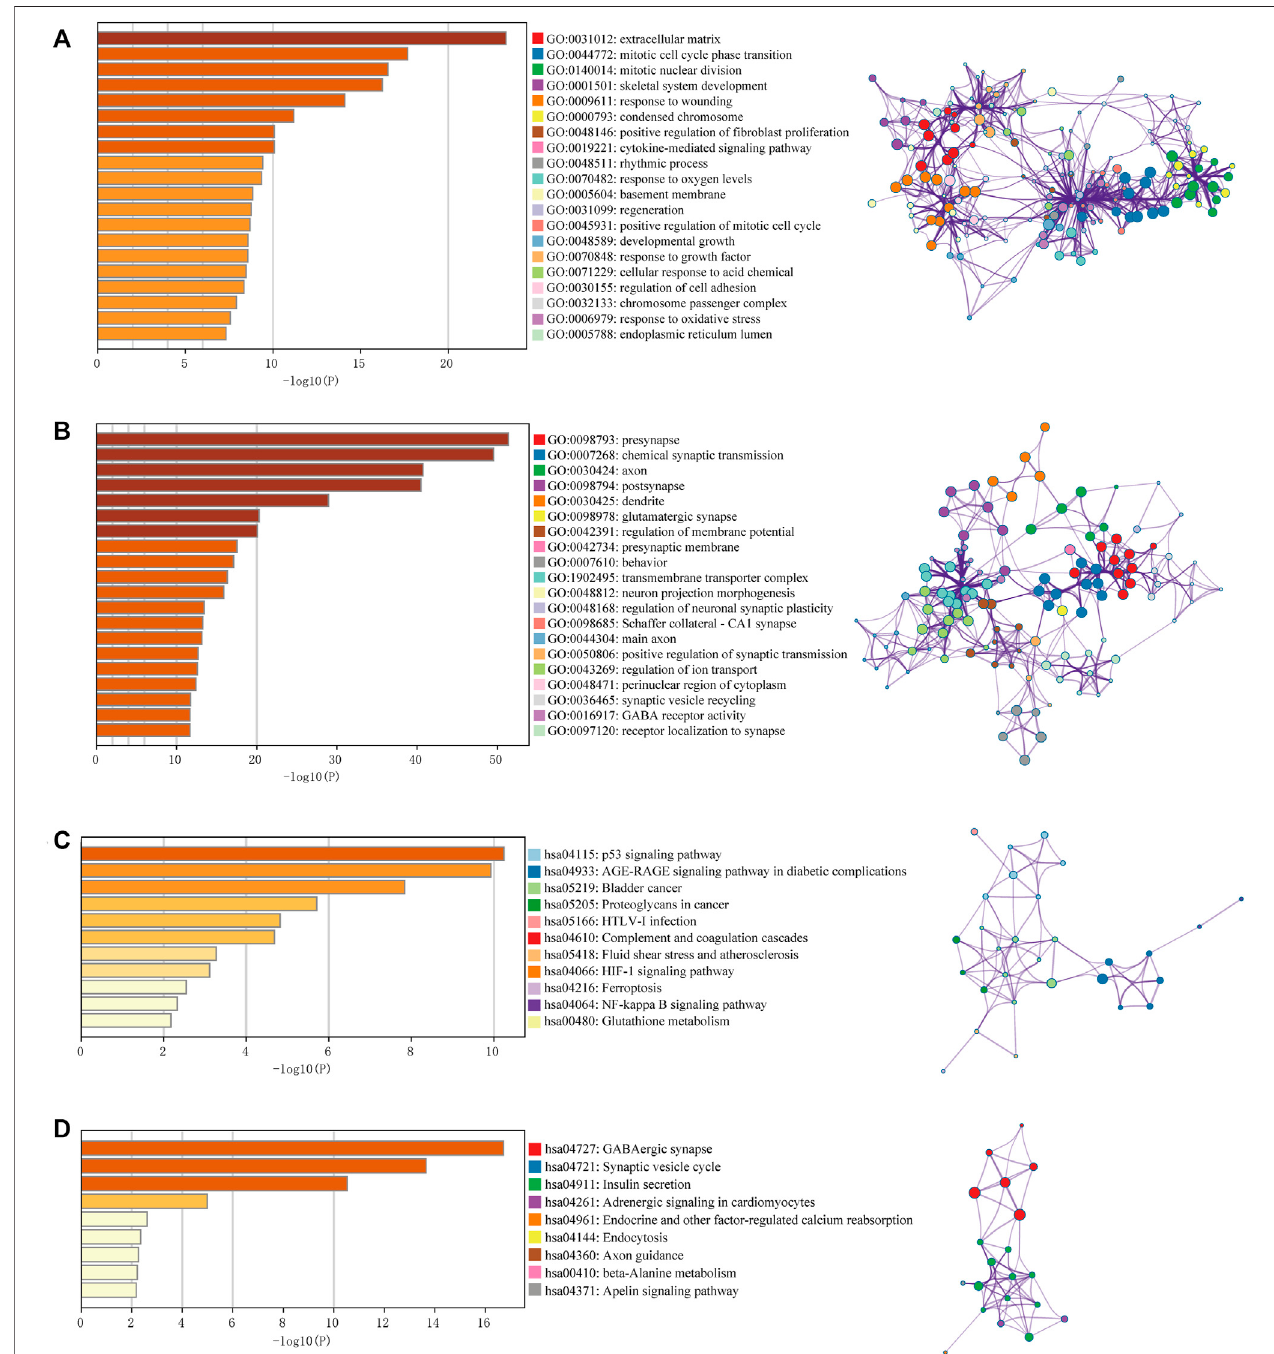
FIGURE 3 | Gene Ontology (GO) term and Kyoto Encyclopedia of Genes and Genomes (KEGG) pathway analysis for DEGs. GO results of the intersecting upregulated genes (A) and downregulated genes (B) . KEGG results of the intersecting upregulated genes (C) and downregulated genes (D) . The relationships among the enriched clusters from the GO and KEGG analyses were visualized with Metascape (http://www.metascape.org/).